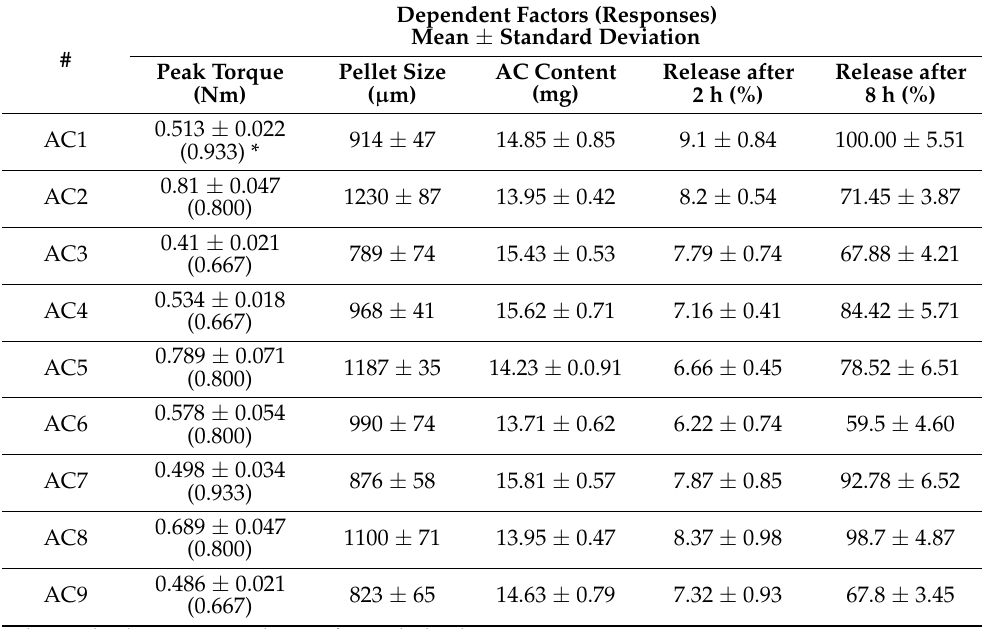
Figure 2. 3D response surface plots for ( a ) mean line torque, ( b ) pellet size, ( c ) release after 2 h, and ( d ) release after 8 h of AC sustained-release matrix pellets. Table 3. Properties of AC sustained-release matrix pellet